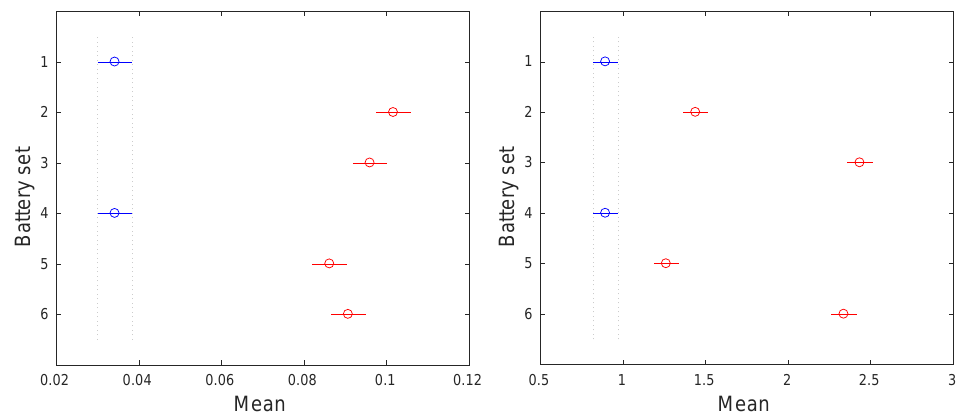
Figure 8. The post-hoc analysis of means of temperature ( left ) and voltage ( right ) ranges during charging period.